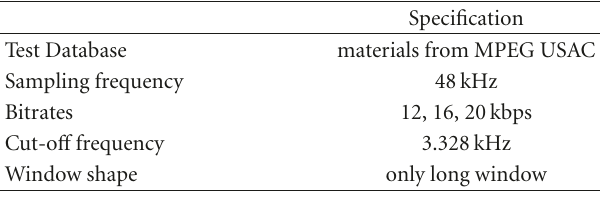
Table 3: Simulation environment.